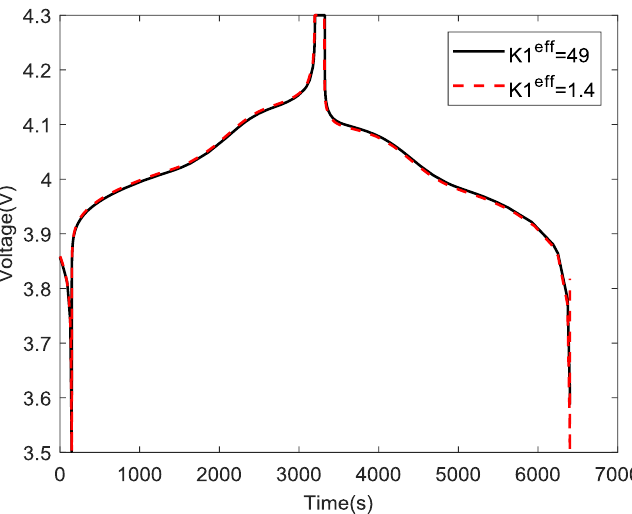
eff K = 49, 1 = 49, 1.4).